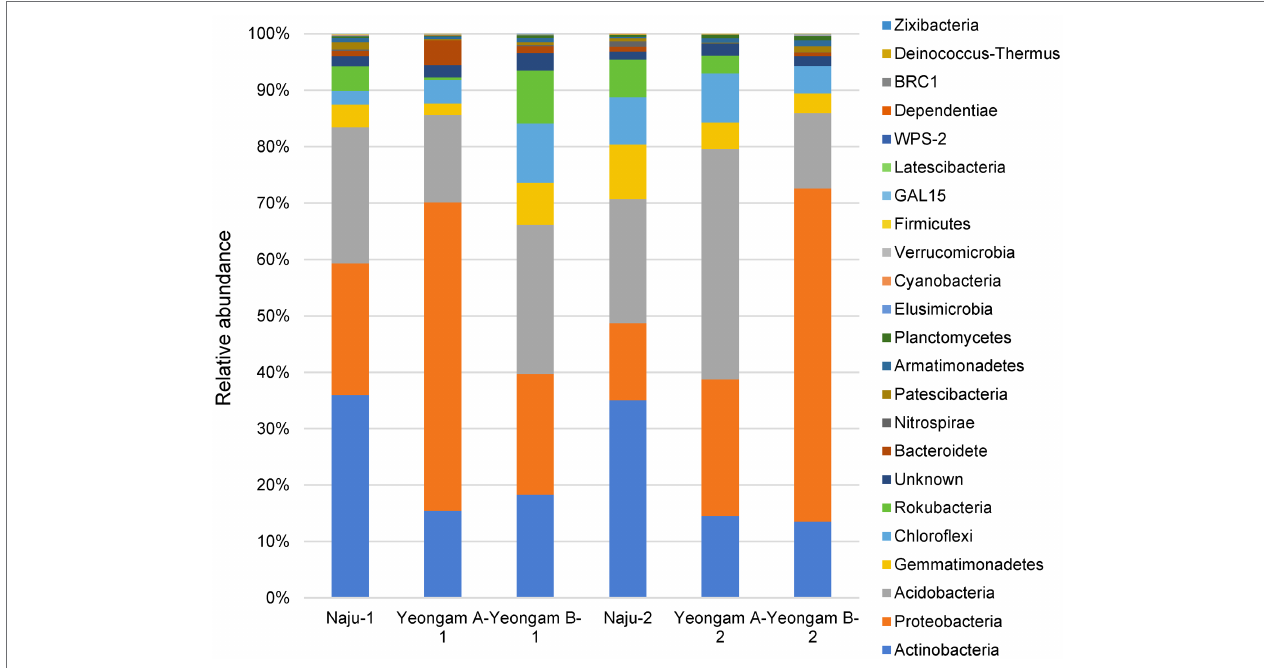
FIGURE 4 | Relative abundance at the phylum level in bacterial communities. Each bar represents the average relative abundance of triplicates.